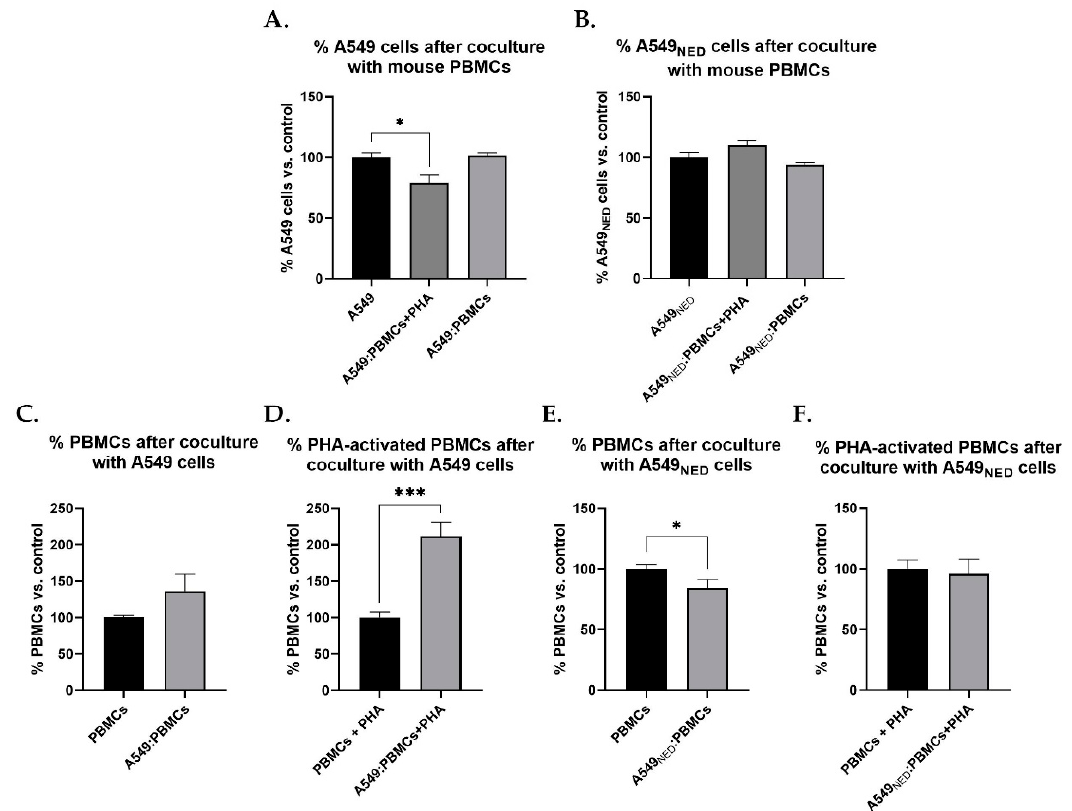
Figure 6. Adenocarcinoma and mononuclear cells after cocultures. The number of A549 ( A ) and A549 NED ( B ) cells is expressed as a percentage relative to the negative control—cells without coculture. Cells were cocultured at a 1:2 ratio (A549:PBMC) with or without PBMC pre-treatment using phytohemagglutinin (PHA). Untreated ( C ) or PHA-activated ( D ) PBMC number after coculture with A549 cells is also shown, as well as the number of untreated ( E ) or PHA-activated ( F ) PBMCs after coculture with A549 NED cells, all expressed as a percentage relative to the negative control. Cells were cocultured at a 1:2 ratio (A549:PBMC) (n = 3, * p < 0.05, *** p < 0.001).